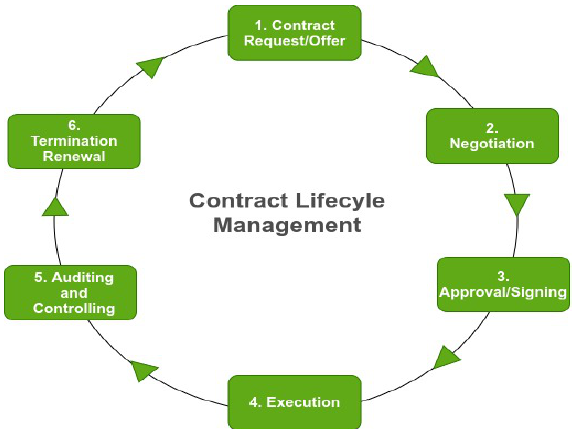
Figure 1. Contract lifecycle